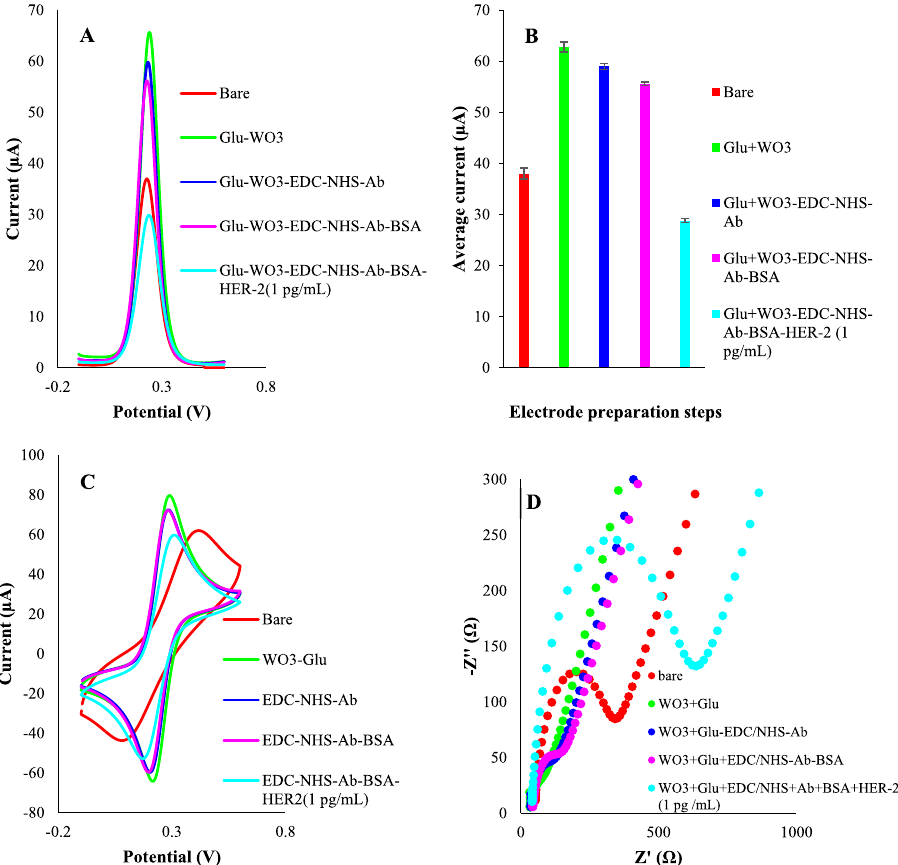
Figure 1. Different steps of electrode preparation. ( A ) the DPV voltammograms and ( B ) correlated histograms for each preparation step. ( C ) CVs and ( D ) impedance responses of different modification steps. The electrochemical measurements were obtained in a PBS buffer (pH = 7.4) of 5 mM K 4 [Fe(CN) 6 ] and 0.1 M KCl. All the DPV measurements were obtained in tha potential range of − 0.1 to 0.6 V with pulse amplitude of 5 mV with interval time of 0.5